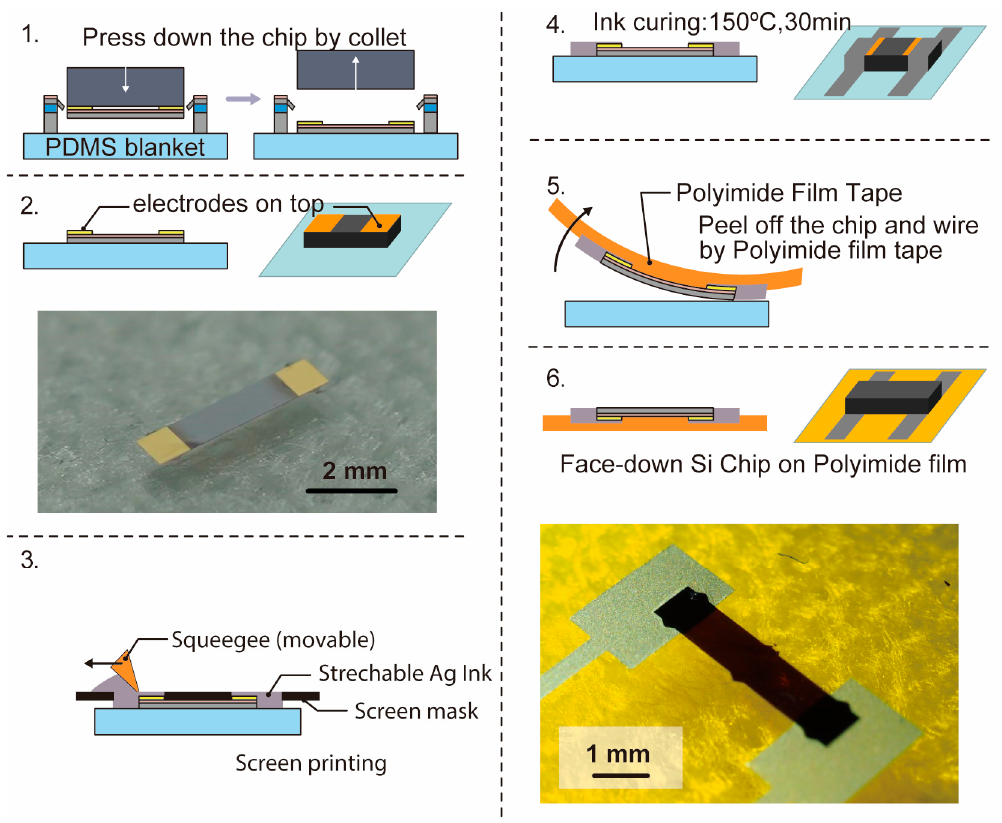
Figure 5. Process outline of transferring the face-down ultrathin Si chip and wiring on a polyimide film tape.